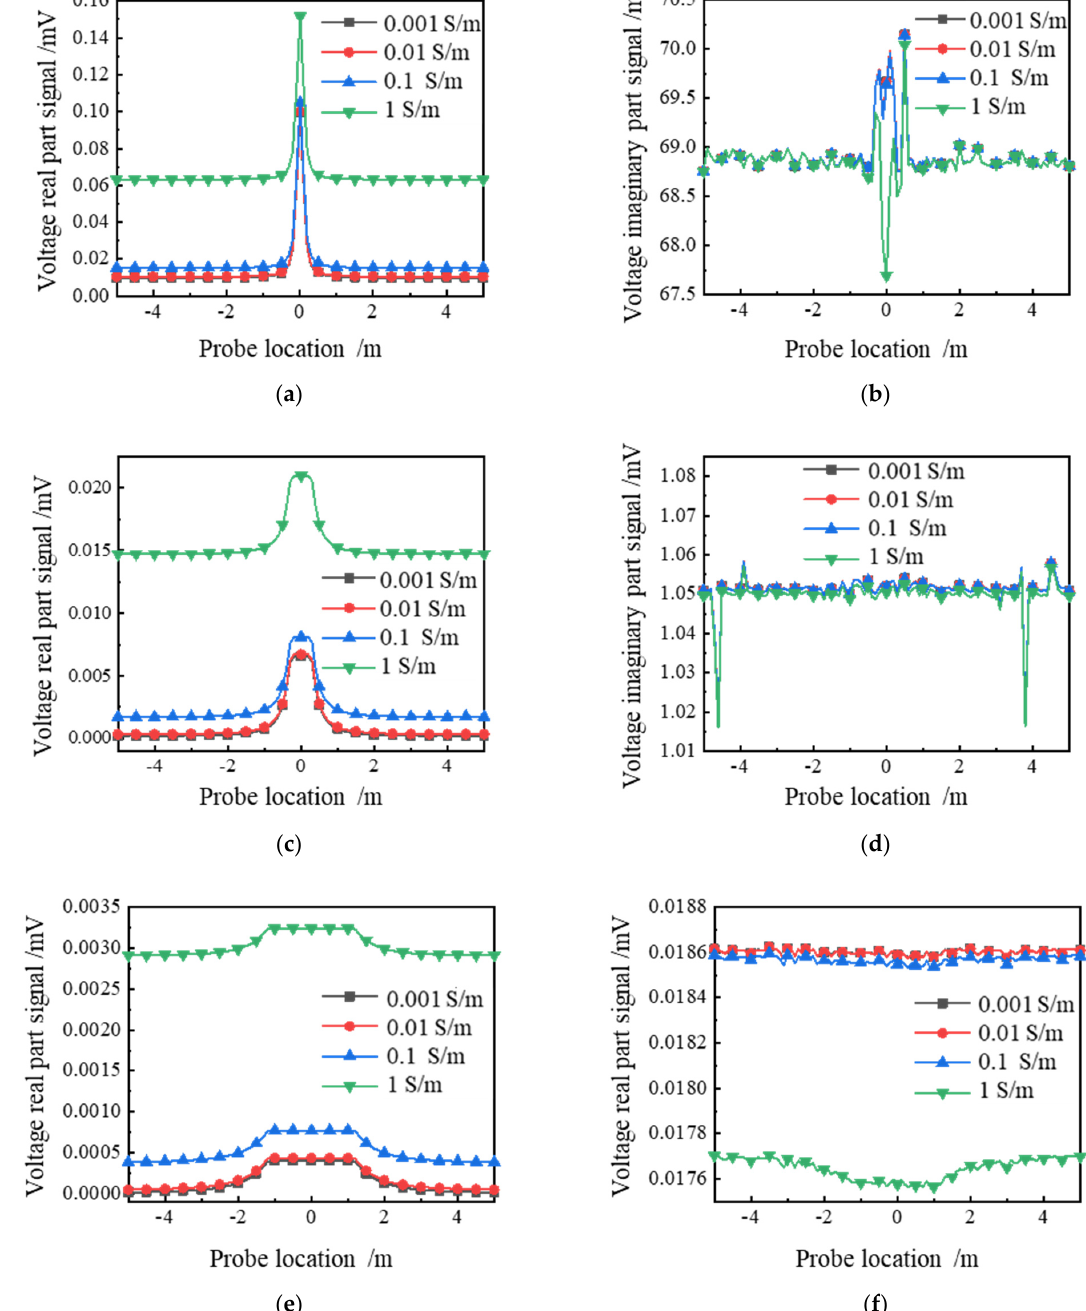
Figure 6. Electromagnetic signal response curves under different formation conductivities: ( a ) real part signal of subarray 1; ( b ) imaginary part signal of subarray 1; ( c ) real part signal of subarray 4; ( d ) imaginary part signal of subarray 4; ( e ) real part signal of subarray 7; ( f ) imaginary part signal of subarray 7.